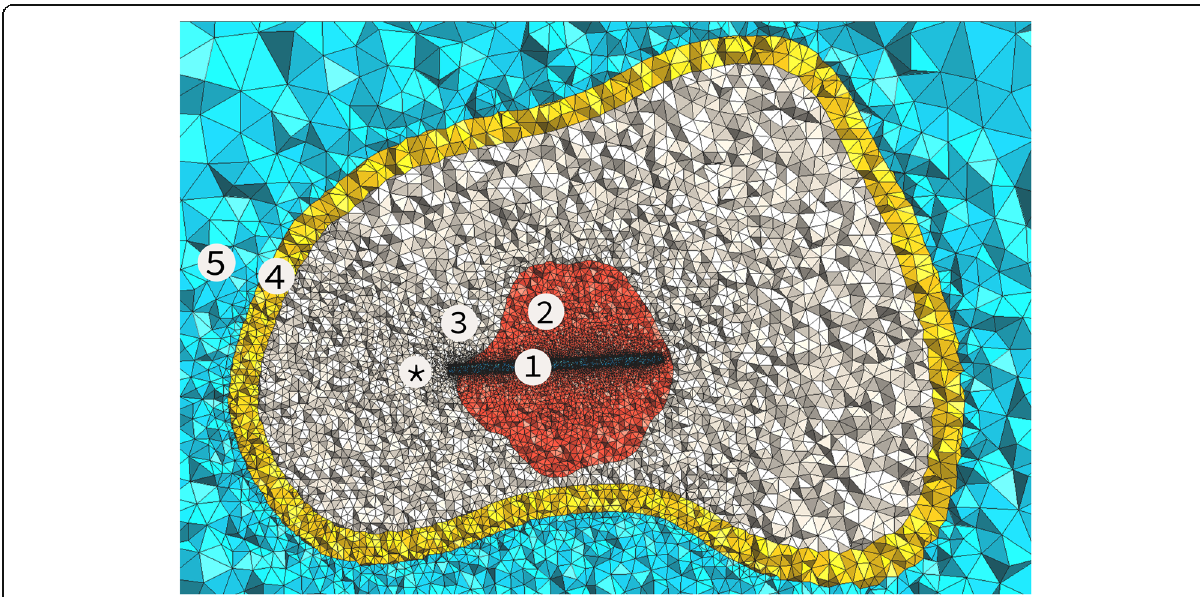
Fig. 1 Cross-sectional view of one of the cases. The numbers indicate (1) the electrode, (2) tumour, (3) trabecular bone, (4) cortical bone, and (5) muscle. Boundary conditions were applied on the surface of the electrode and the outer surface of the muscle layer. *Indicates the bottom surface of the electrode was thermal and electrical no-flux boundary conditions were